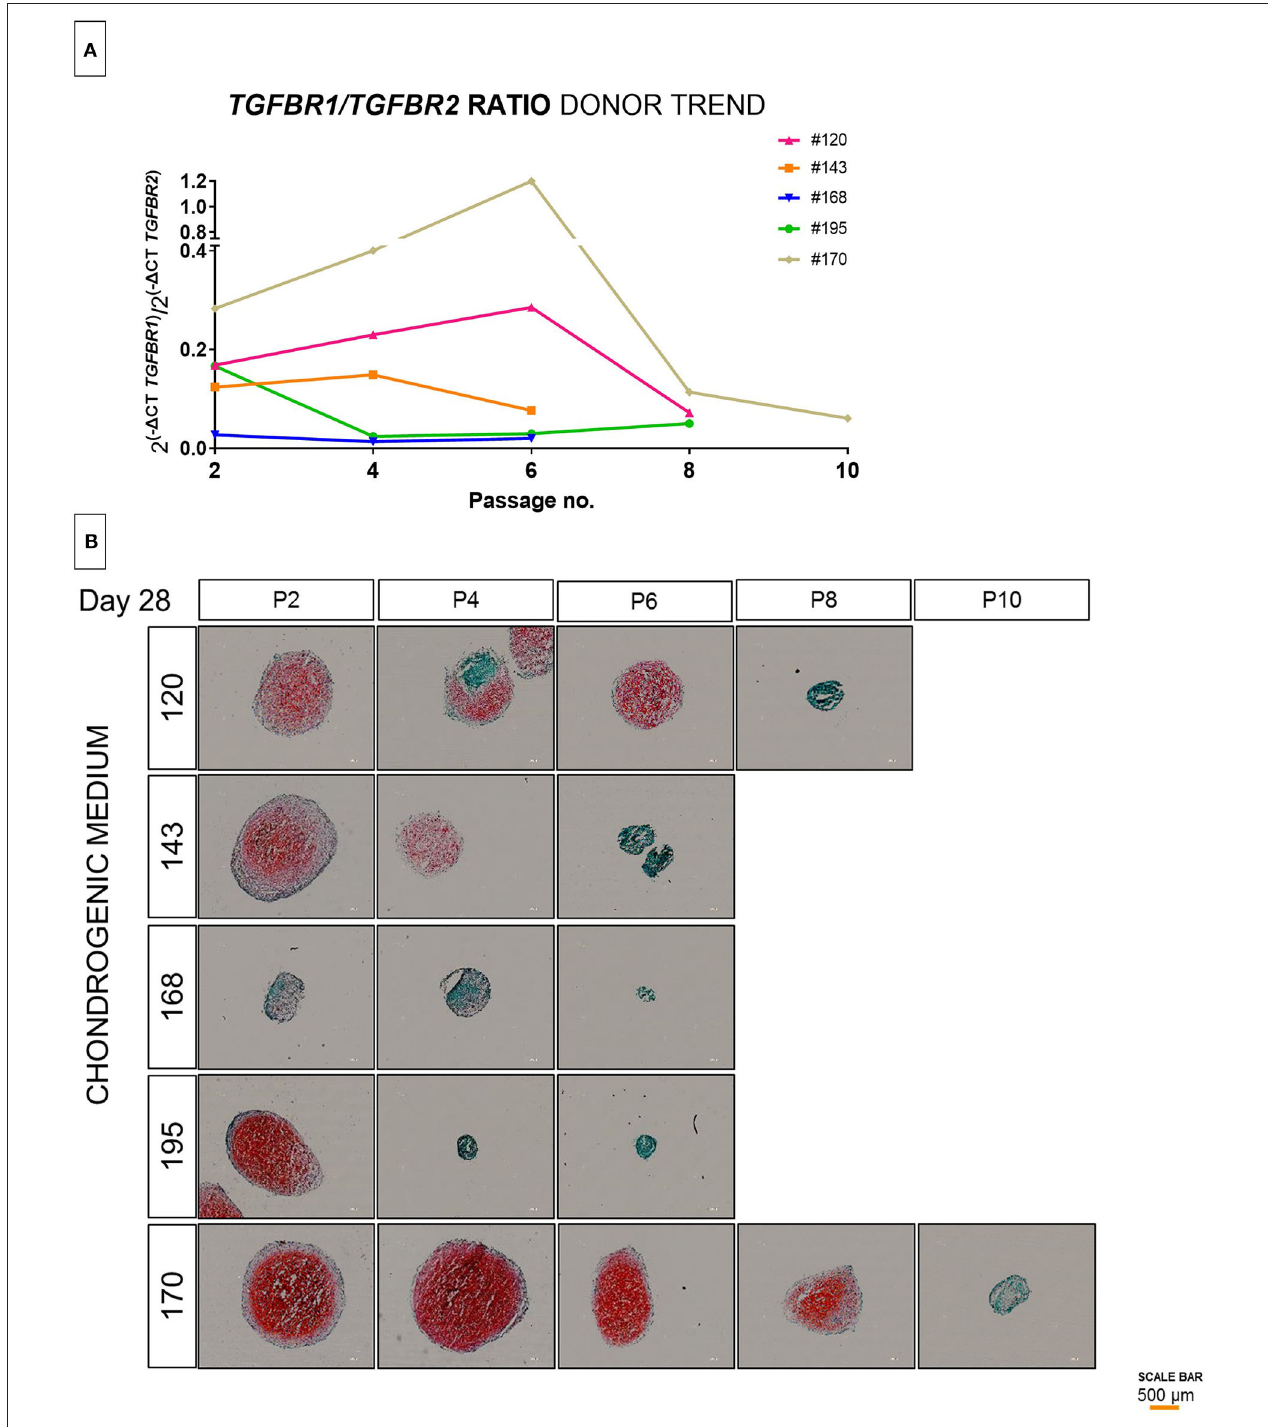
FIGURE 2 | Evaluation of TGFBR ratio in extended population during monolayer expansion of hBMSCs from passage 2 to passage 10. Cells from different donors were cultured in conventional expansion medium. The amounts of TGFBR1/TGFBR2 ratio mRNA was normalized to ribosomal protein large, P0 (RPLP0). The mRNA expression of cells cultured over the passaging were plotted as 2 [ − ( 1 Ct _1 − 1 Ct _2)] (A) , the lines shows the trend of individual donors over passaging (B) . Histological representation by safranin-O and fast green of 5 donors correlating to the initial observation of TGFBR1/TGFBR2 ratio and outcome of differentiation (C) . Red scale bar is 200 µ m.